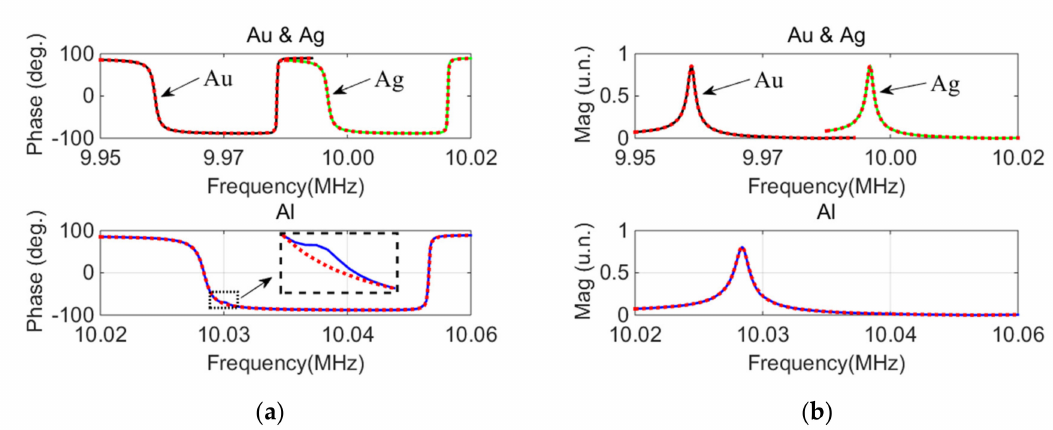
Figure 8. Measured curve and inversion curve of QCM resonator devices with different electrode materials: ( a ) phase– frequency curve; ( b ) magnitude–frequency curve.